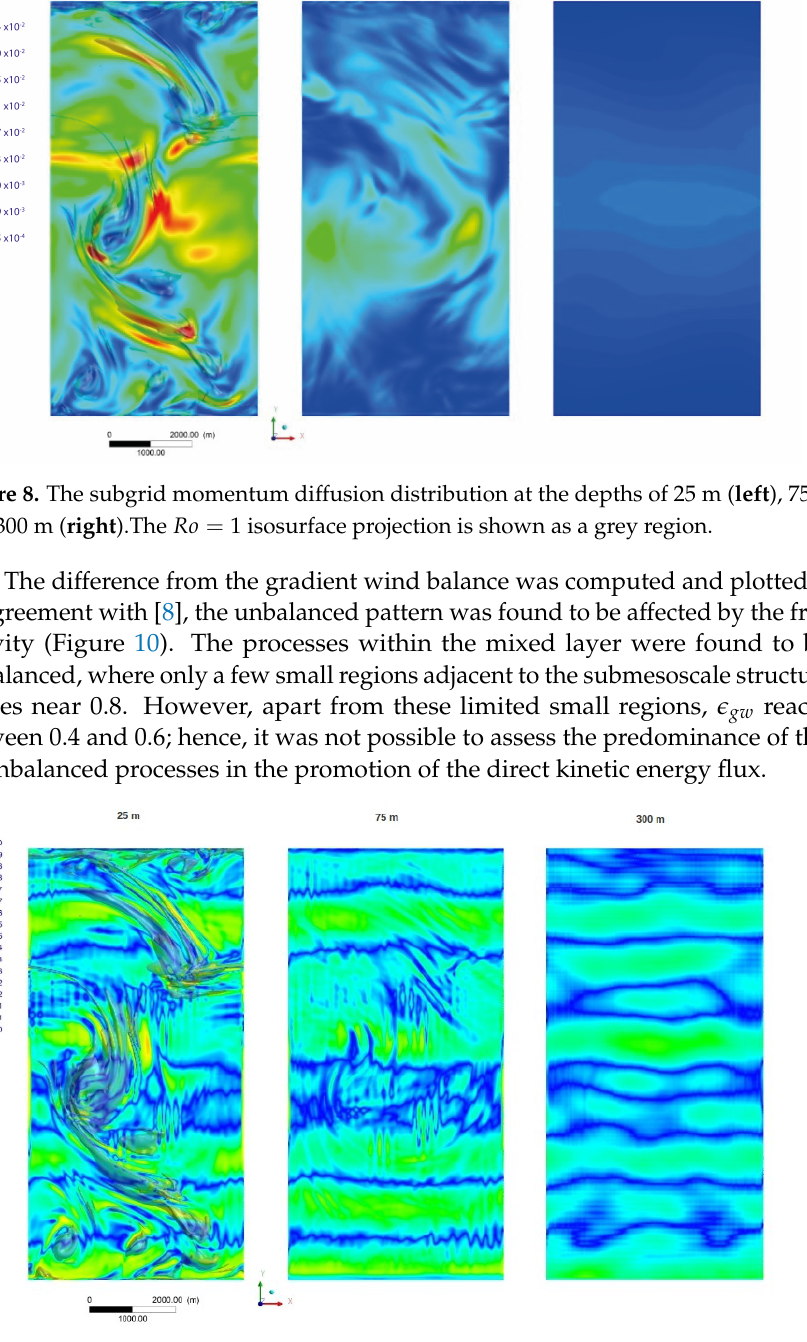
Figure 9. The error in the wind gradient balance at the depths of 25 m ( left ), 75 m ( middle ), and 300 m ( right ). The Ro = 1 isosurface projection is shown as a grey